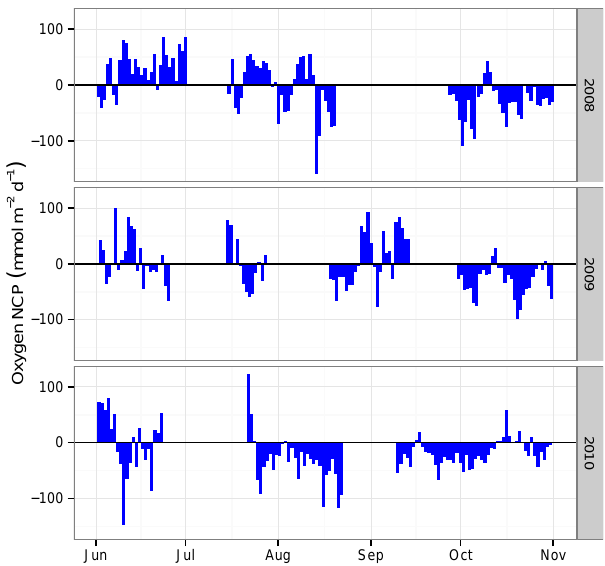
Figure 6. Warp June–October NCP estimates from other years demonstrating no significant periods of net